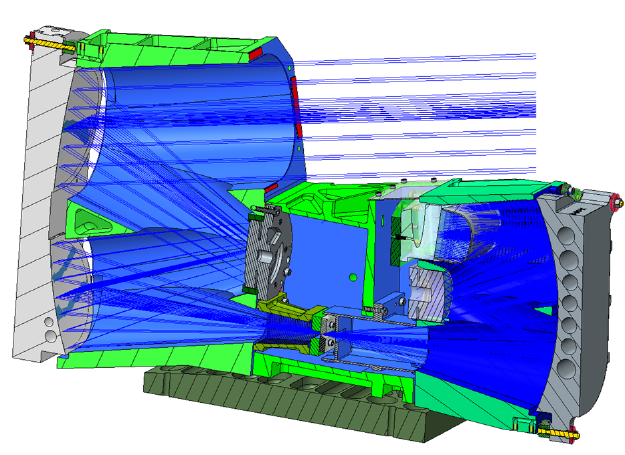
Figure 4. Case of spectrometer optics.